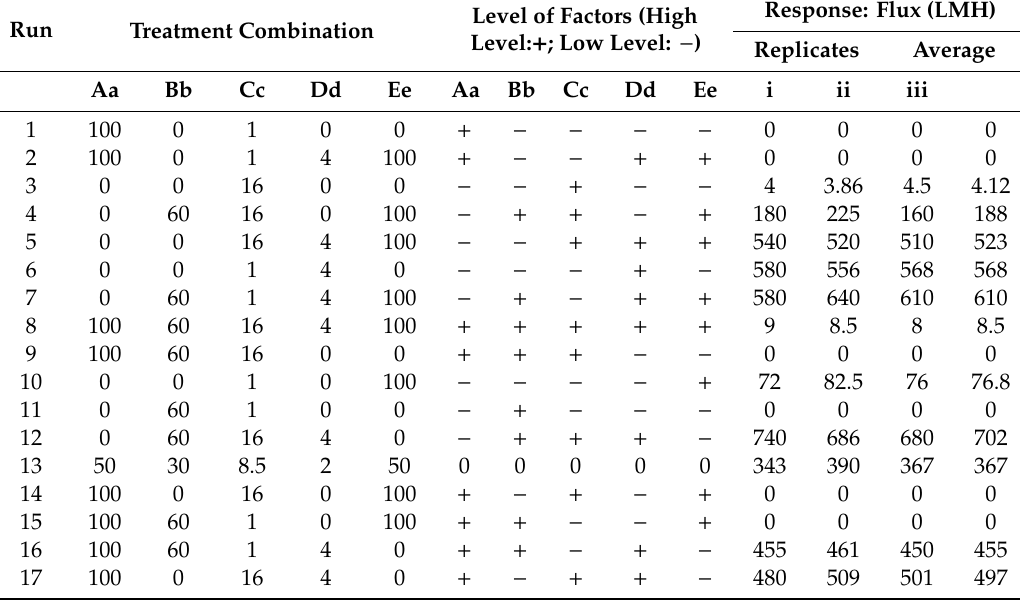
Table 1. One-half fractional factorial design (response: